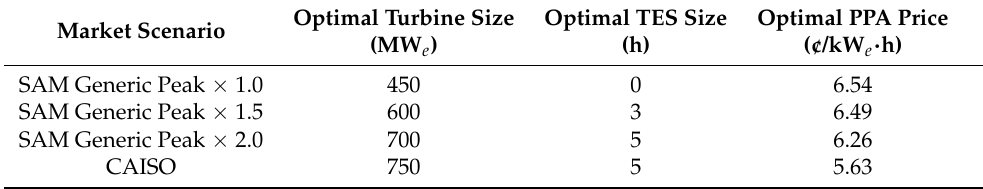
Table 4. Optimal plant designs and corresponding PPA prices per market.